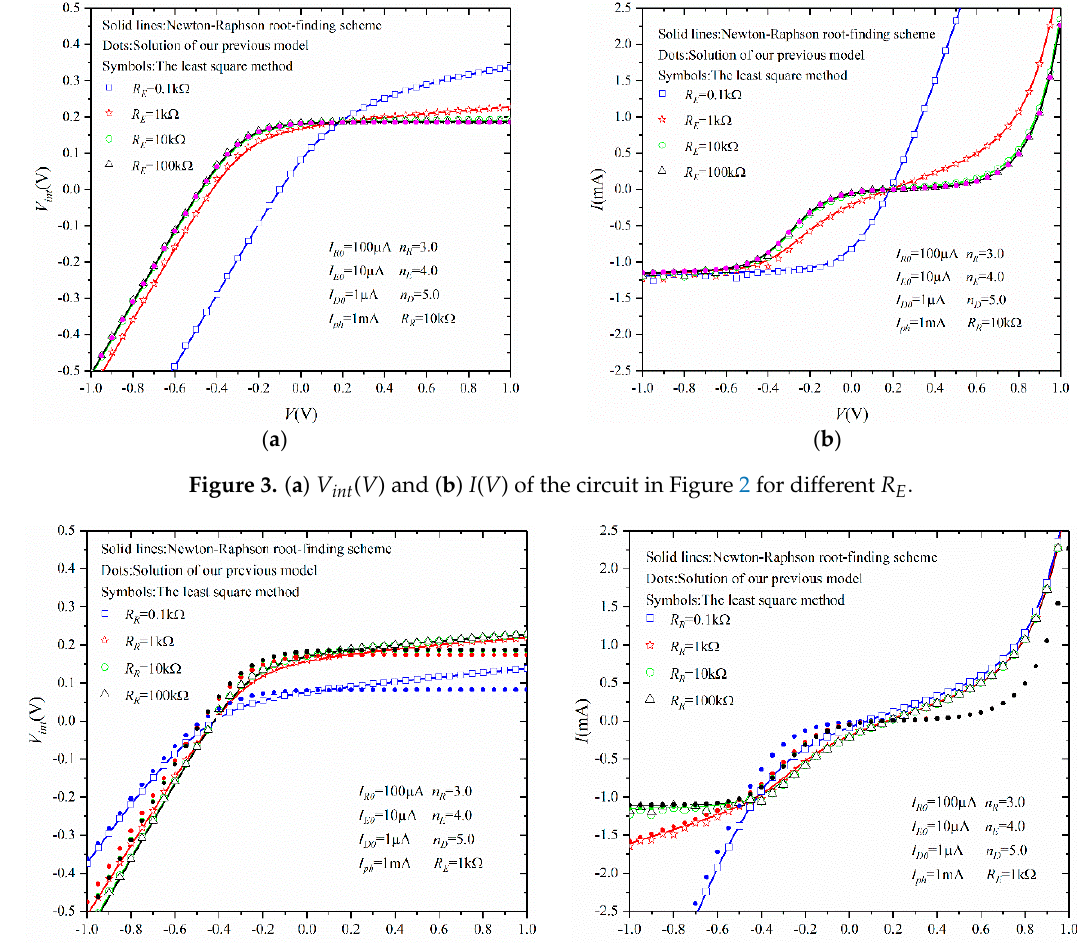
( b ) Figure 5. ( a ) V int ( V ) and ( b ) I ( V ) of the circuit in Figure 2 for different I ph .